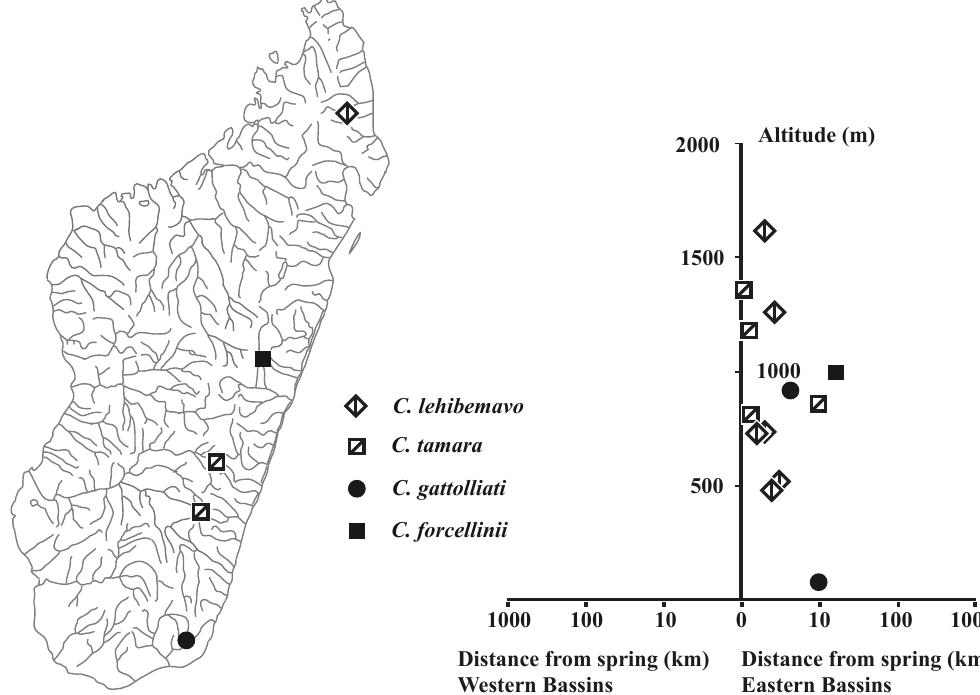
Fig. 16. Chimarra lehibemavo sp. nov., Chimarra tamara sp. nov., Chimarra gattolliati sp. nov. and Chimarra forcellinii sp. nov., schematic distribution map and ecological profile of the capture sites in